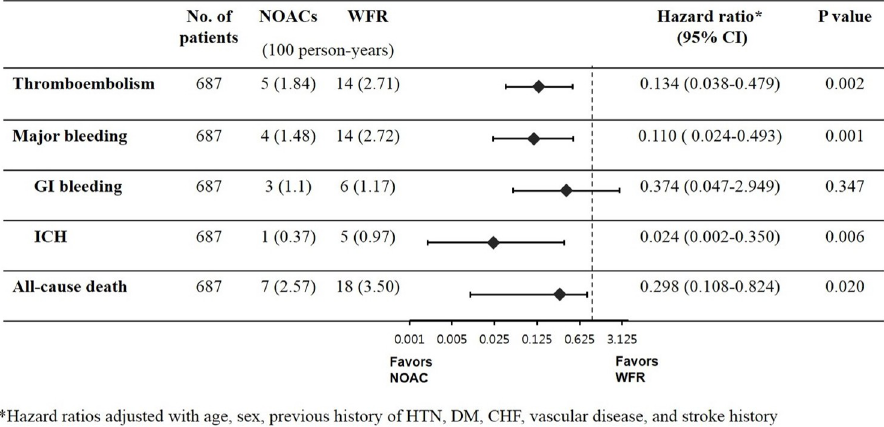
Fig 1. Clinical outcomes based on the treatment group. Hazard ratio adjusted with age, sex, previous history of hypertension, diabetes mellitus, congestive heart failure, vascular disease and stroke history. NOAC, non-vitamin K antagonist oral anticoagulants; WFR, warfarin; GI, gastrointestinal; ICH, intracranial hemorrhage.